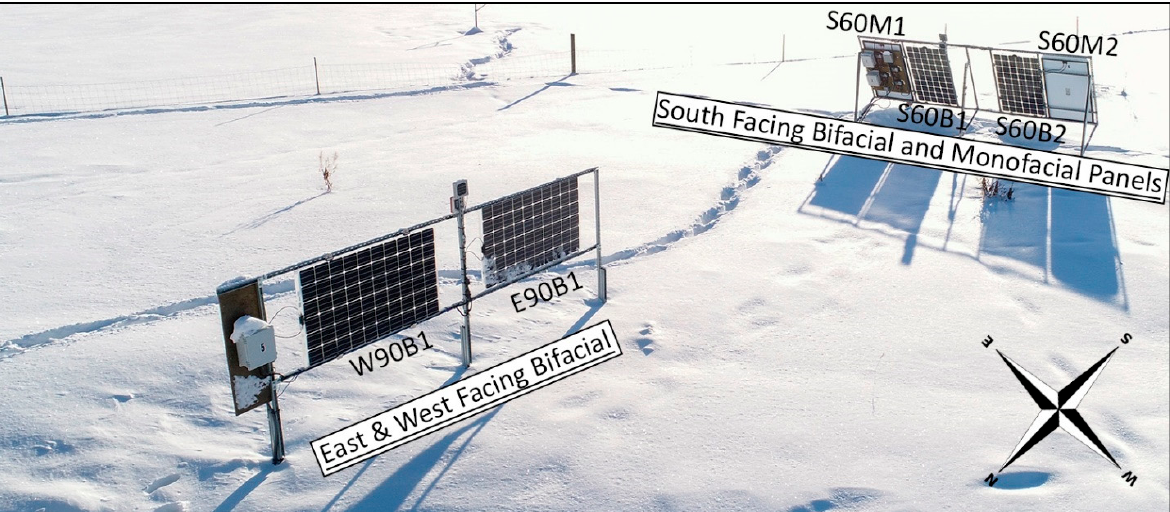
Figure 1. The solar photovoltaic (PV) bifacial test site on the campus of the University of Alaska Fairbanks at 64° N.